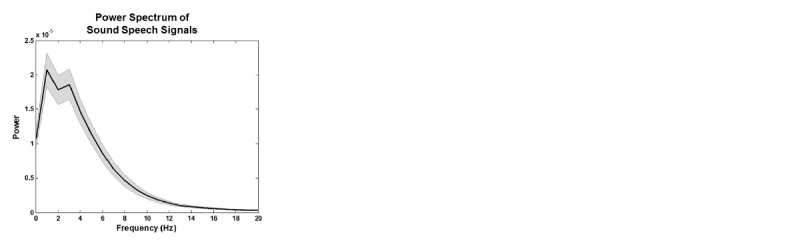
DOI:
http://dx.doi.org/10.7554/eLife.14521.012